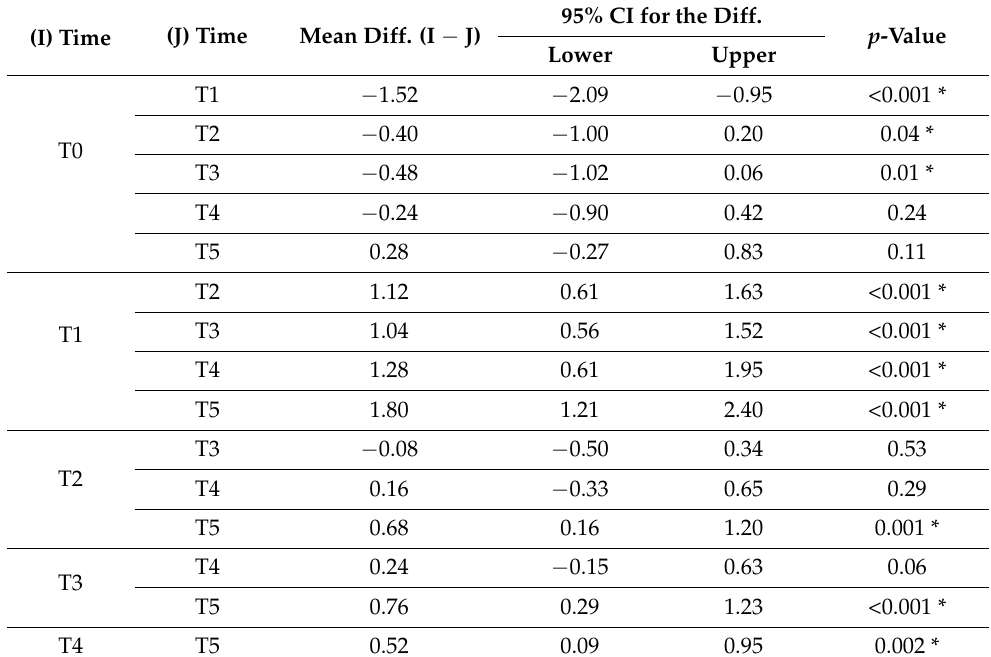
0.005.0010.0015.0020.0025.0030.0035.00